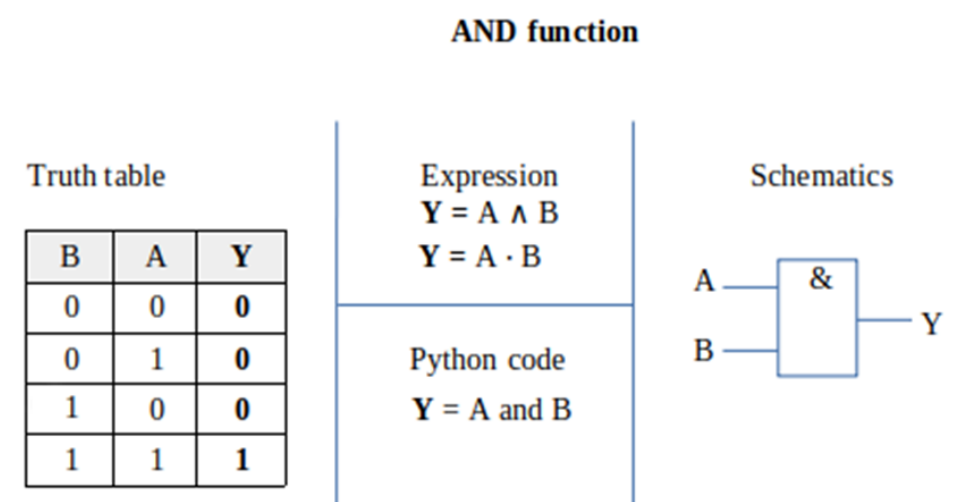
Figure 6. Description of one of the logic functions (fAND) with Python code included.